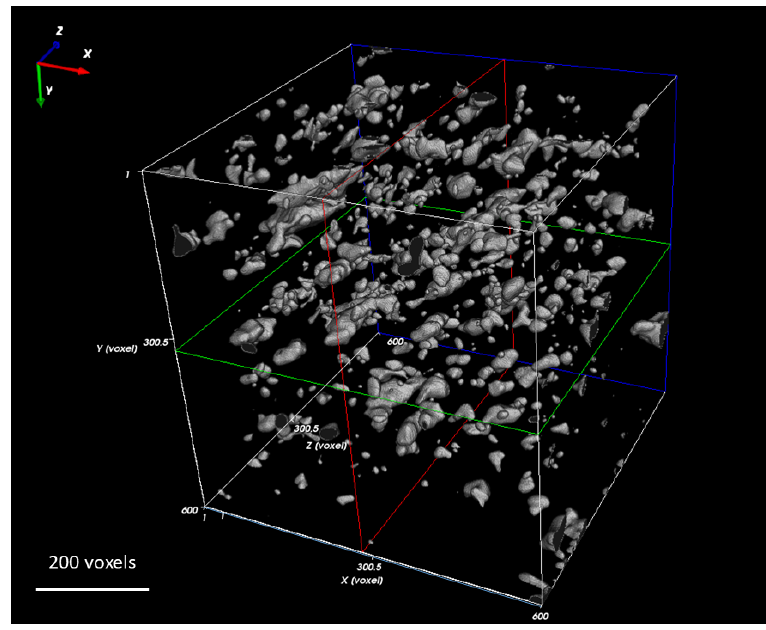
Figure 2. Pore space of tight sandstone (sample 20), poROSE software. Energies 2021 , 14 , 2628